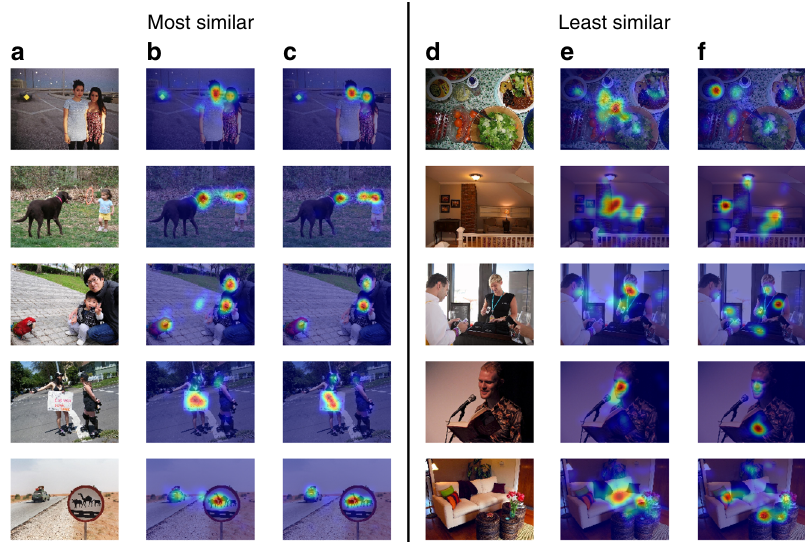
Fig. 7 Comparison between mobile and desktop gaze for natural image viewing. The left hand side shows the most similar mobile vs. desktop heatmaps, while the right hand side shows the least similar heatmaps. Columns refer to: a and d original image; b and e mobile gaze heatmap with a blur width of 24 px; c and f desktop gaze heatmap with a blur width of 24 px (corresponding to 1 ∘ desktop viewing angle). See Supplementary Fig. 9 and Supplementary Table 1 for similar results with a larger blur width of 67 px (corresponding to 1 ∘ mobile viewing angle).